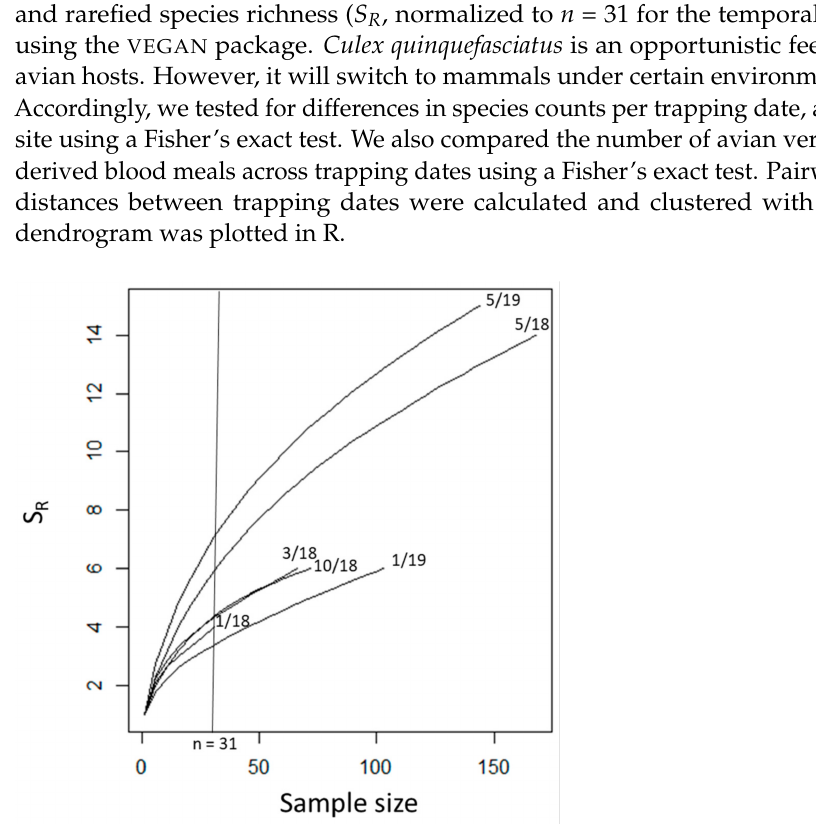
Figure 2. Rarefaction curves for vertebrate species identified from mosquito blood meals collected at six trapping dates in the San Juan Metropolitan Area, Puerto Rico. The x-axis is sample sizes, the y-axis is species richness ( S R ), and the vertical line represents the small sample size, which was used for rarefaction. The tips of each curve are labeled with the trapping date in the month/year